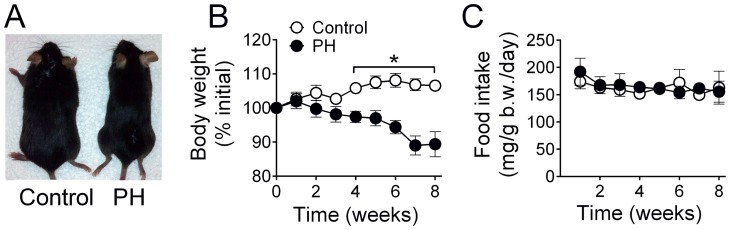
Progressive decrease in body weight and unchanged food intake in mice treated with monocrotaline to induce pulmonary hypertension (PH).A) Images of sample mice in each group at the end of study illustrating that PH mice are smaller than controls. B) Body weight expressed as percentage of value at the onset of study. C) Food intake expressed as mg per g body weight per day in each week of the study period. Data are from mice receiving control and monocrotaline injections for 8 weeks (N = 4 for Control; N = 5 for PH). * P<0.05 for control vs. PH.